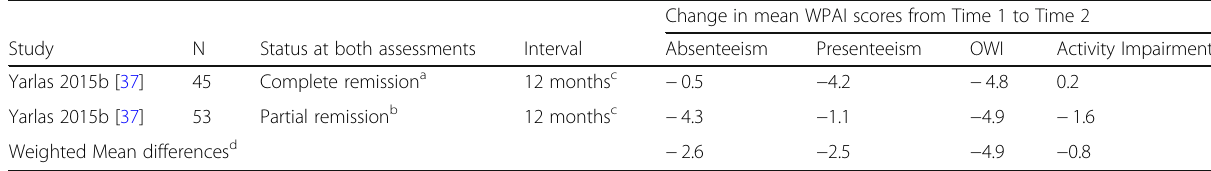
Table 2 Changes in WPAI scores over time for patients with no change in UC disease activity